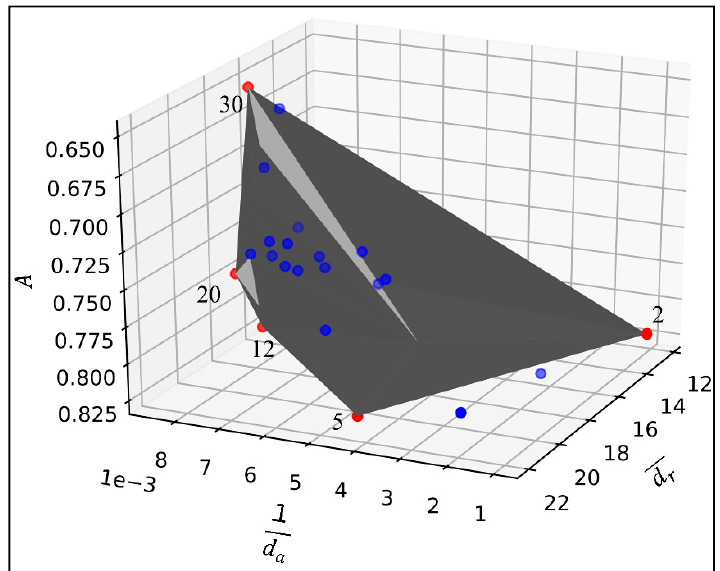
Figure 6. A three-dimension visualization of the Pareto surface associated with different K . The red dots indicate the nondominated solutions, and the blue dots indicate the dominated solutions. The grey surface is the Pareto frontier surface.